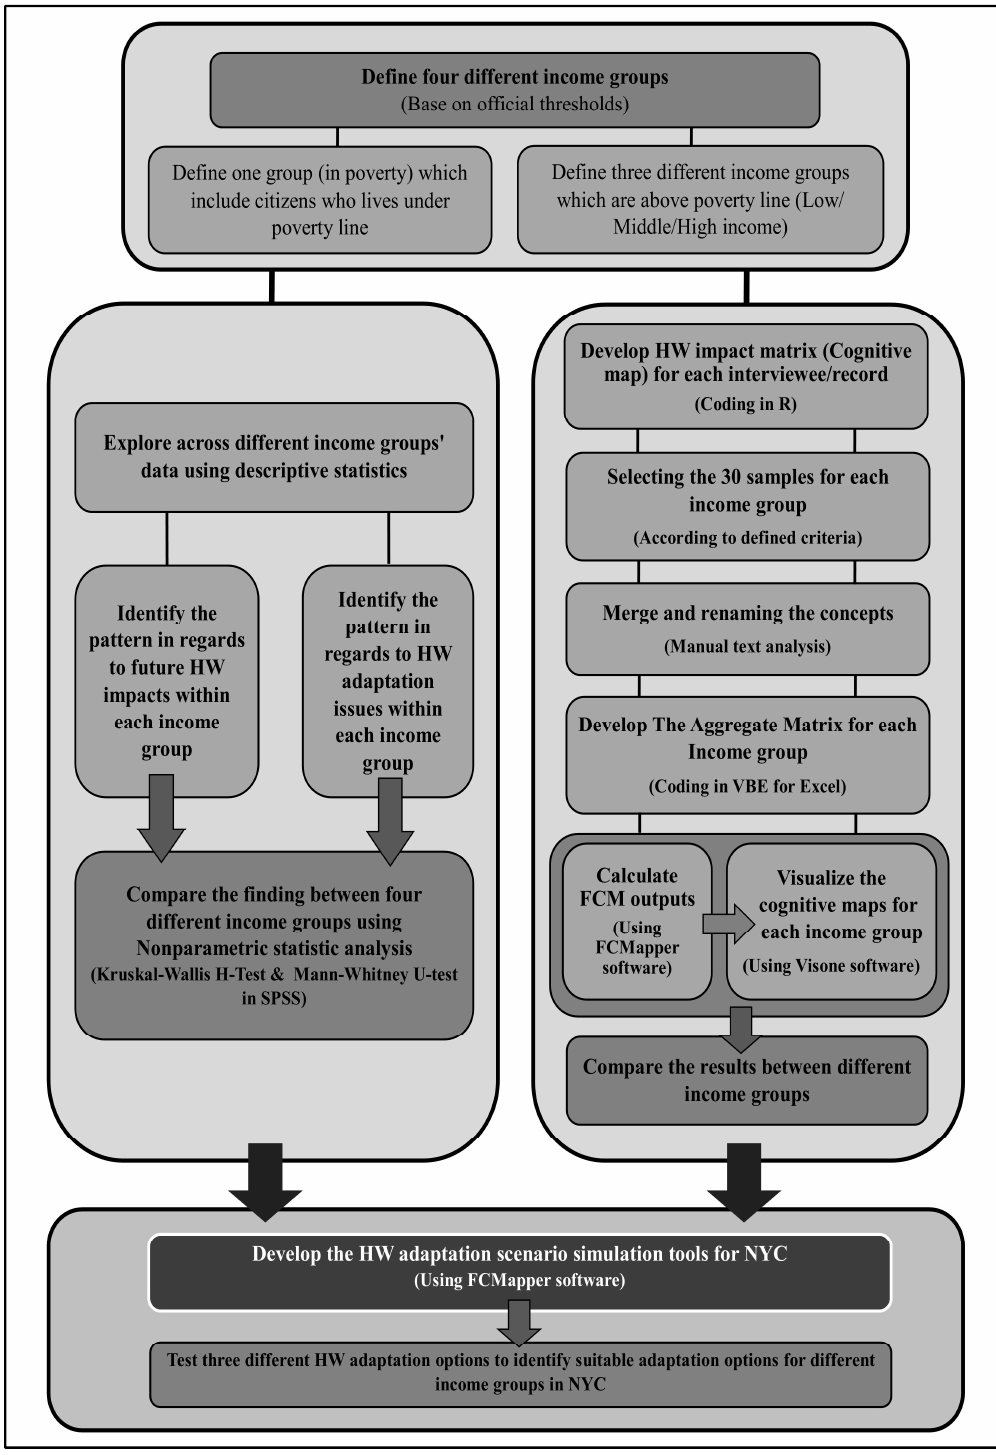
Figure 3. Flowchart of research methodology.